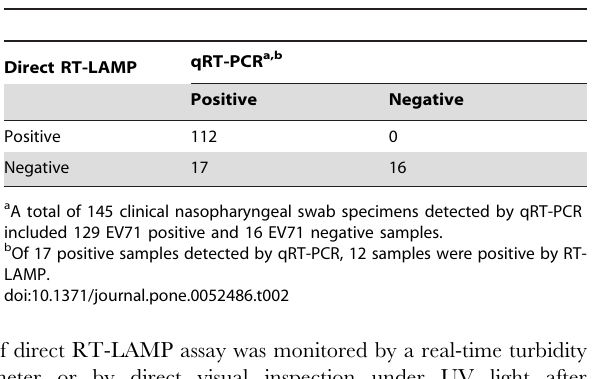
Table 2. Comparison of results of direct RT-LAMP assay with qRT-PCR assays obtained from 145 clinical nasopharyngeal swab specimens.